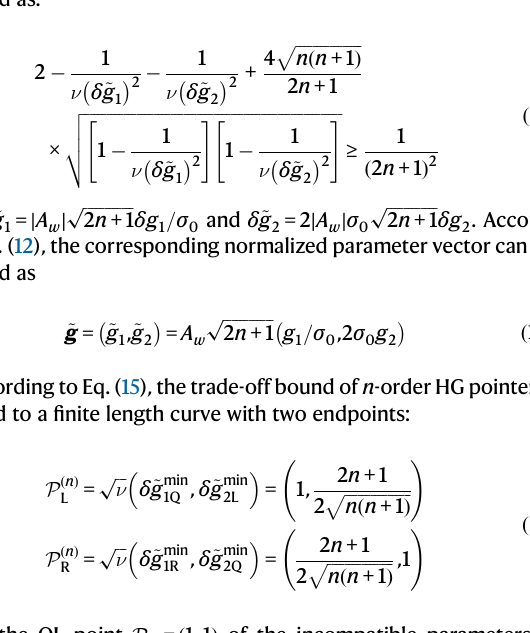
− 1 pointer. The gray shadow region between these two curves is named as HG n region,whichisallowedforHG n pointerbutforbiddenforHG n − 1 pointer. c Practical precisionlimits of HGpointerwhenemploying directimaging and non-orthogonal projection measurements. The blue solid curve is the trade-off bound of HG n pointer. The green solid curve is the joint CCR bound under direct imaging mea- surement. The black dashed lines are the CCR bounds under with non-orthogonal projection measurement, where the cross point (yellow X mark) is the corre- sponding precision limit